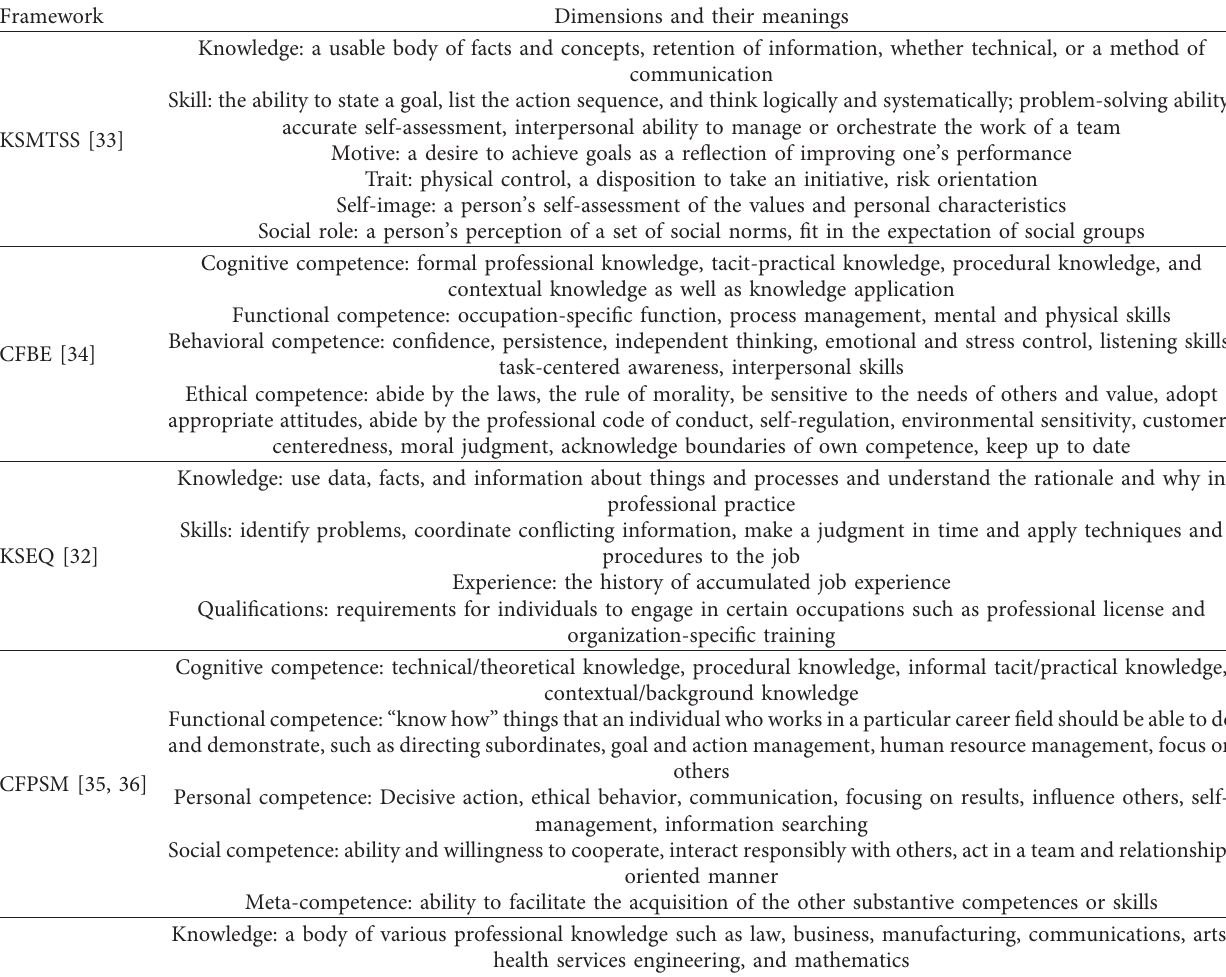
Table 1: Frameworks for individual